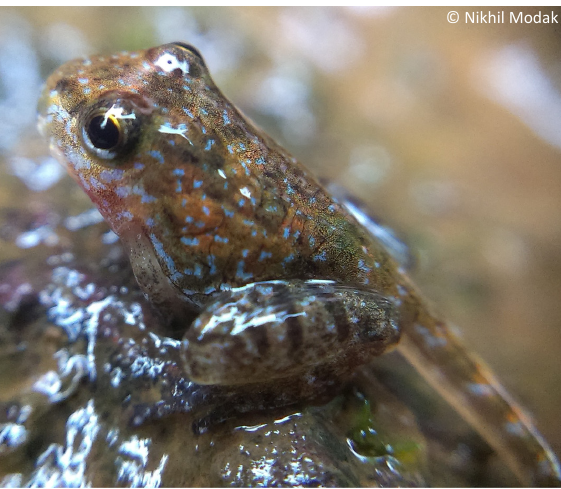
Image 7. Metamorphic stage 45 of Indirana salelkari sp.